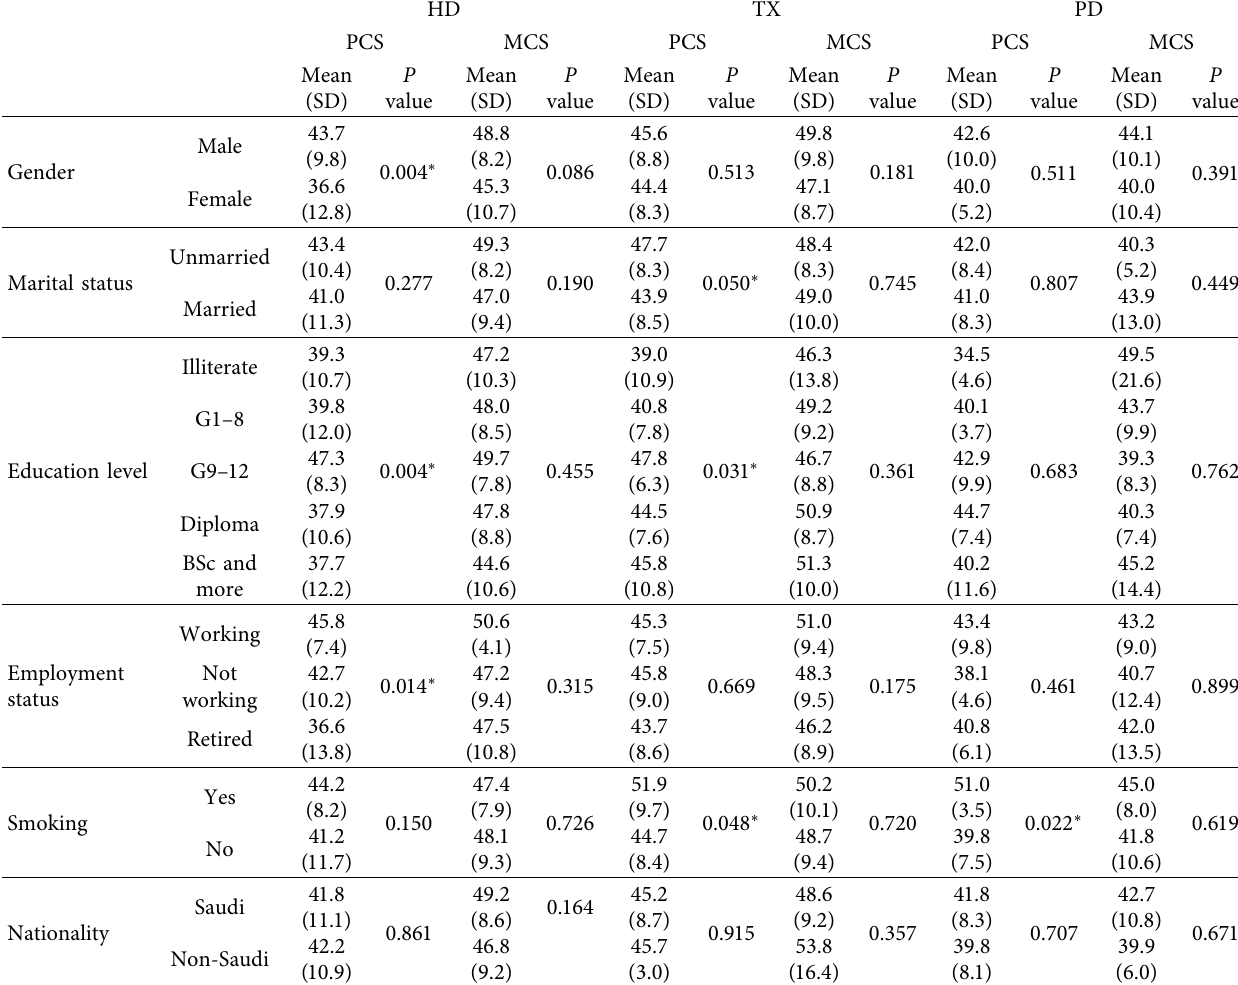
Table 3: The difference between QOL and Demographic